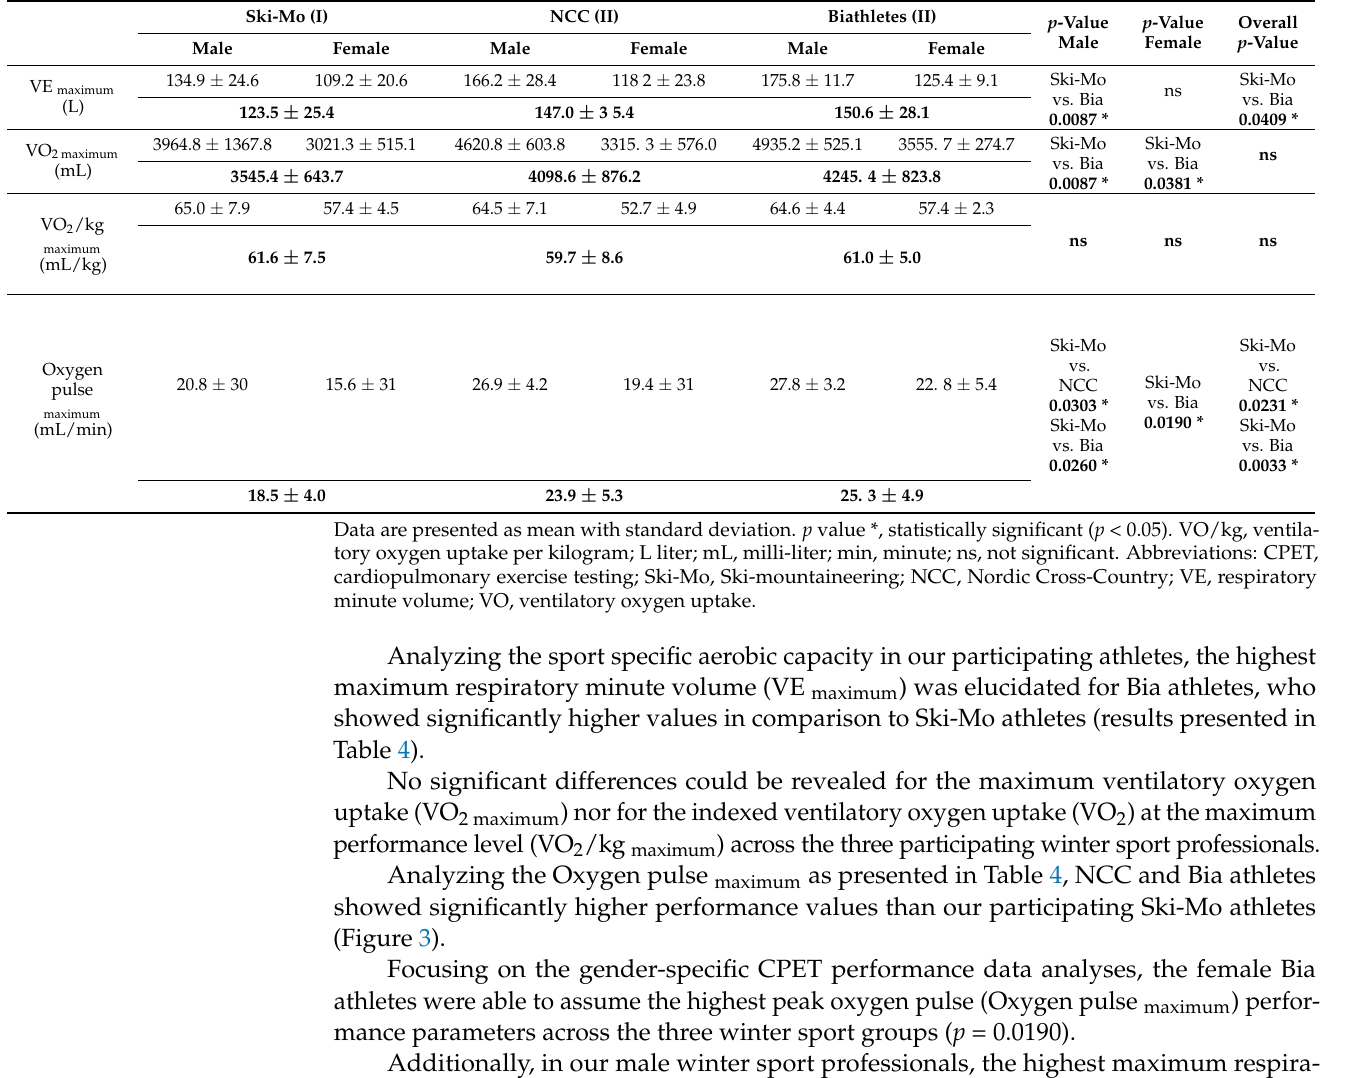
Table 4. Cardiopulmonary Exercise Testing (CPET) performance parameters in elite Winter Sport professionals, adapted from Zimmermann et al., 2022